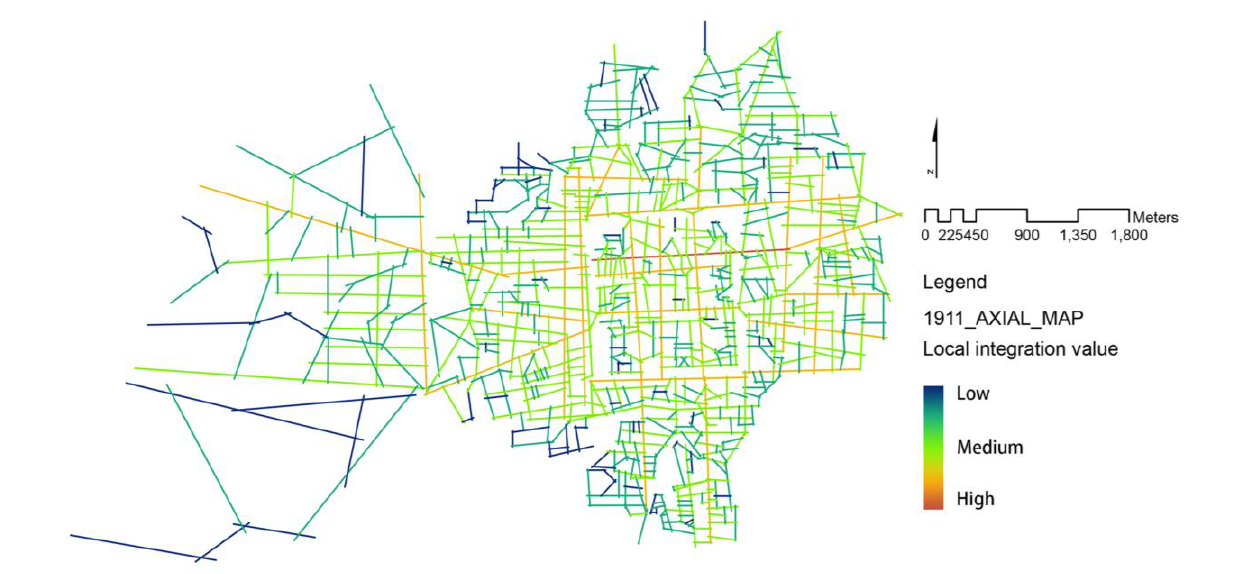
Figure 2. LIV of Shenyang 1911.